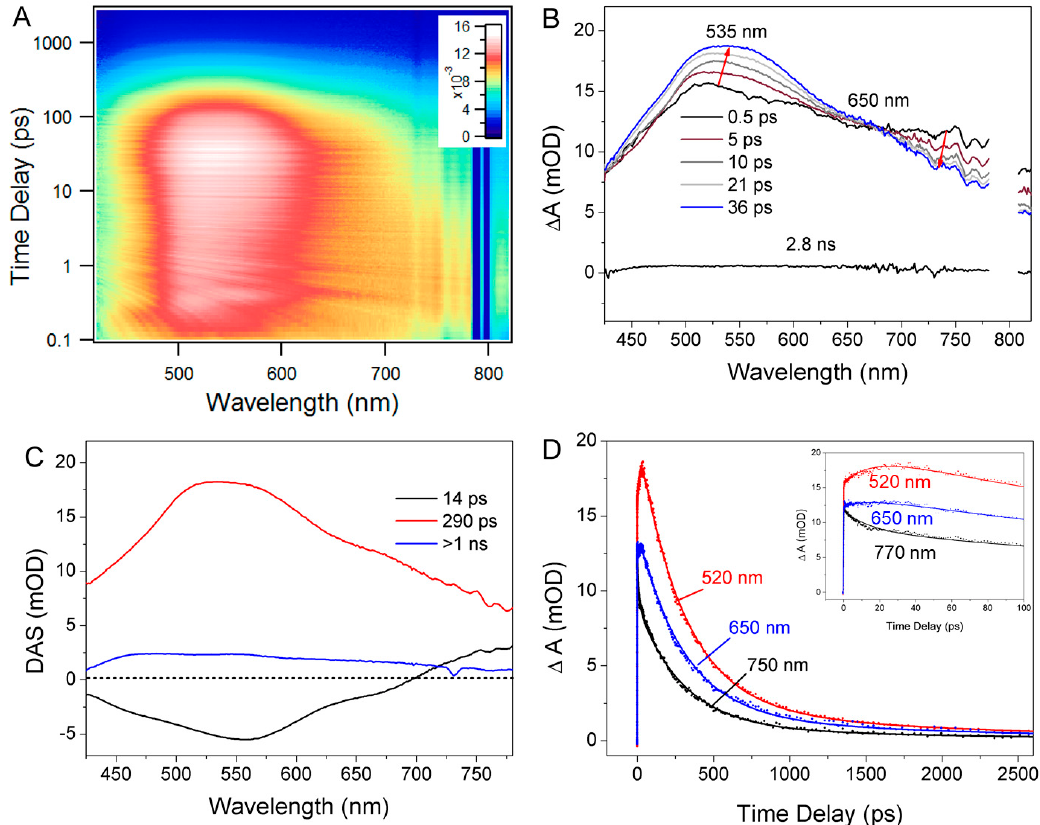
Figure 4. ( A ) Transient absorption (fs-TA) data of Au 10 complex dissolved in dichloromethane. ( B ) Transient absorption spectra as a function of time delay from 0.5 ps to 36 ps and that at 2.8 ns. Scattering due to the laser pulse was excluded around 800 nm for ( A ) and ( B ). ( C ) Decay associated spectra (DAS) obtained from the global analysis of the TA data. ( D ) Kinetic traces (dots) and corresponding fit (solid line) at selected wavelengths, which shows the quality of the fitting.